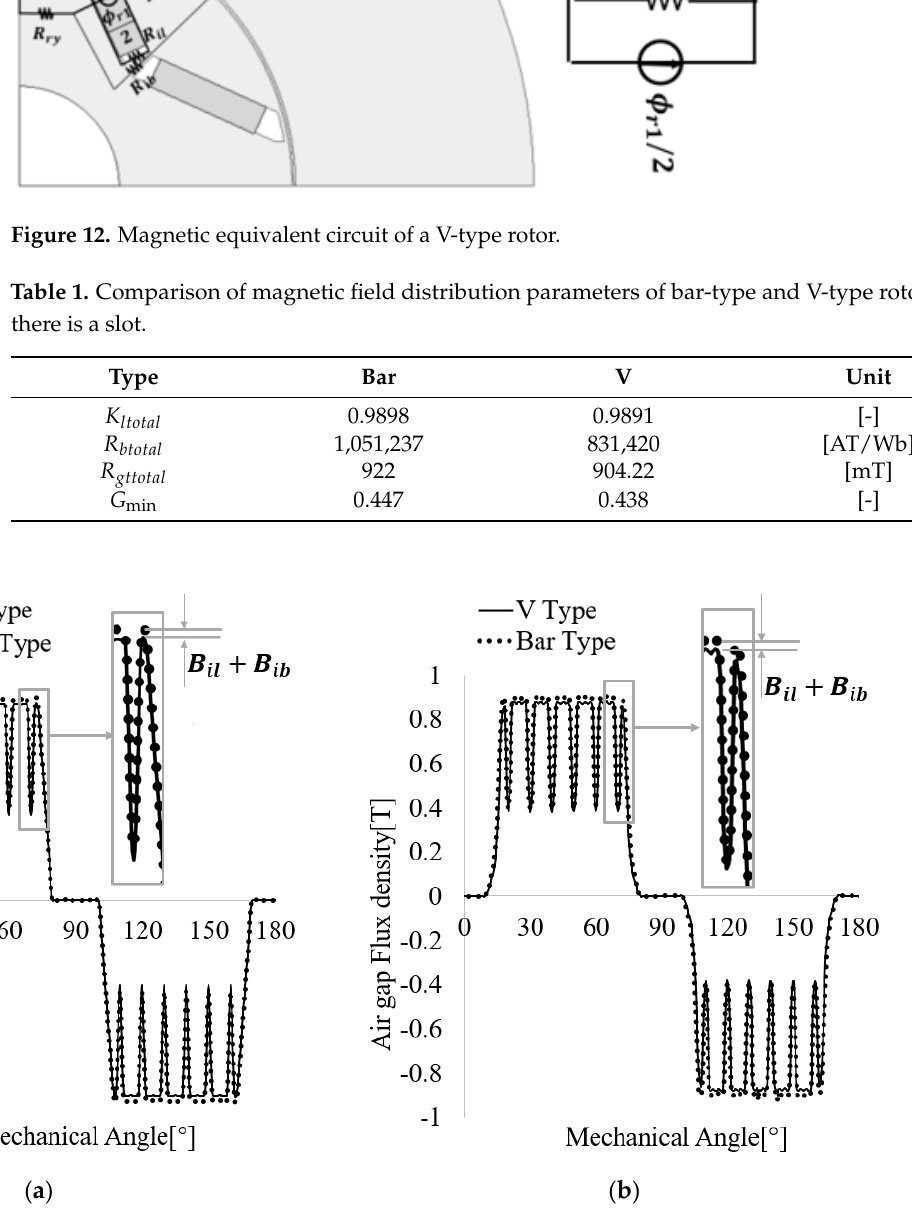
Figure 13. Comparison of flux density distribution of the air gap with bar-type and V-type rotors with slots: ( a ) HMEC, ( b ) FEM.